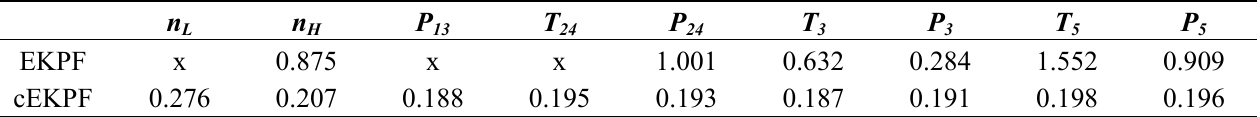
Table 8. Estimation error square sum with the eight measurements in Gaussian system.